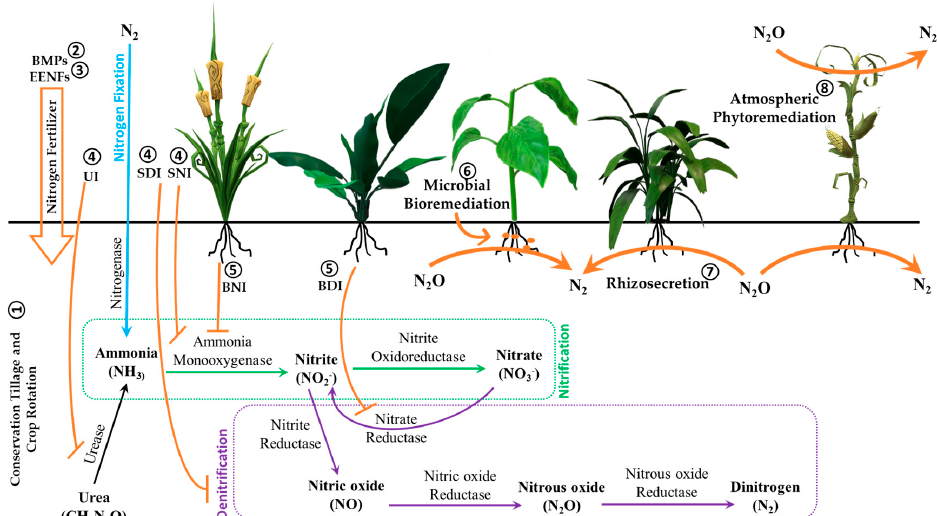
Figure 2. Nitrification-denitrification pathway and overview of current N 2 O mitigation strategies. Orange arrows and lines show eight N 2 O mitigation strategies described in Table 1. Green arrows show nitrification and purple arrows represent denitrification reactions. BDI, biological denitrification inhibitor; BMPs, best management practices; BNI, biological nitrification inhibitor; EENFs, enhanced efficiency nitrogen fertilizers; SDI, synthetic denitrification inhibitor; SNI, synthetic nitrification inhibitor; UI, urease inhibitor. O Encircled numbers refer to Table 1 strategies.